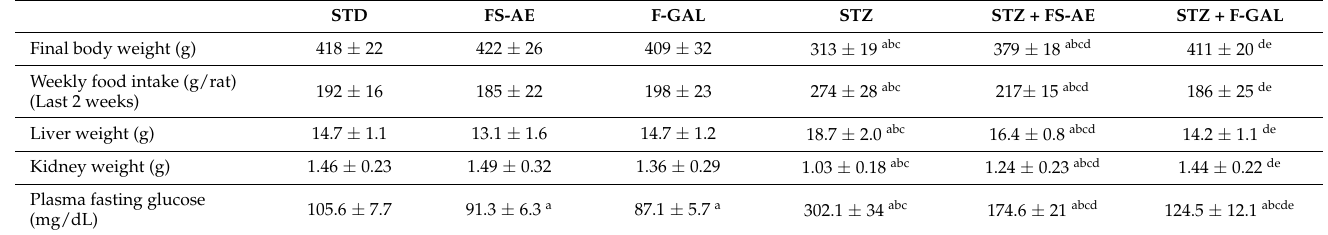
Table 2. Final body and organ weights, food intake, and fasting levels of glucose and insulin in all groups of